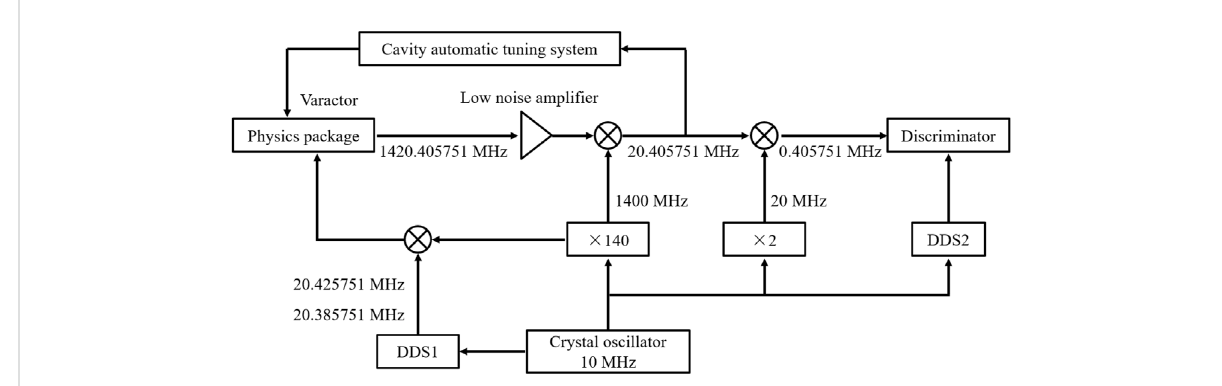
FIGURE 6 Electronicspackage of theactive hydrogen maser. Thelocal signal (1400 MHz) and 1420.405751 MHz output fromthemaserare mixed to give abeatoutputof20.405751 MHz,phasedetectedwithasynthesizedsignalof405.751 kHz.Theoutputofthephysicspackageisaccurately relatedto the quartz oscillator using phase-locked loop. The DDS1 outputs two frequencies alternately to detect the